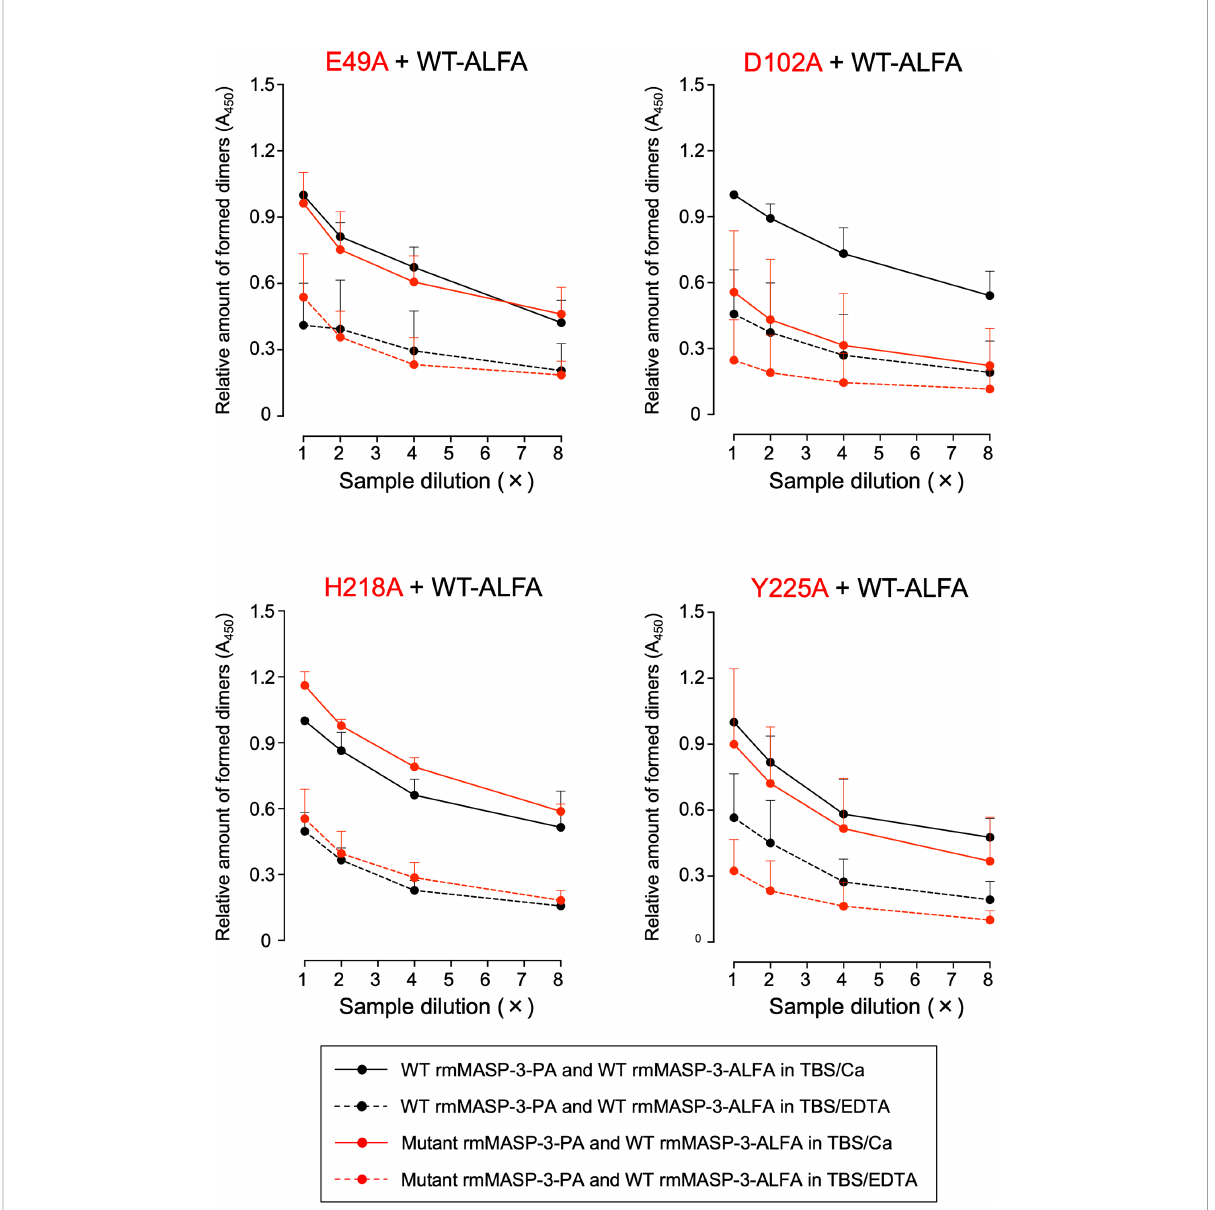
FIGURE 6 Effects of single amino acid mutations on dimer formation of rmMASP-3-PAs with WT rmMASP-3-ALFA. The black circles represent the formed dimer of WT rmMASP-3-ALFA with WT rmMASP-3-PA, and the red circles represent the formed dimer of WT rmMASP-3-ALFA with mutant rmMASP-3-PAs. The solid lines represent the results on protein mixture dialyzed in TBS/Ca for dimer formation, and the dotted lines represent the results on protein mixture dialyzed in TBS/EDTA for dimer dissociation. Values are means + SD ( n = 3) of the ratio of absorbance at 450 nm of each sample against the absorbance at 450 nm of the top dilution of the “ WT-PA and WT-ALFA in TBS/Ca ” sample, which were measured in the same microplate. The values of each sample are obtained by subtracting the absorbance at 450 nm of a control sample without mouse serum from the absorbance at 450 nm of each